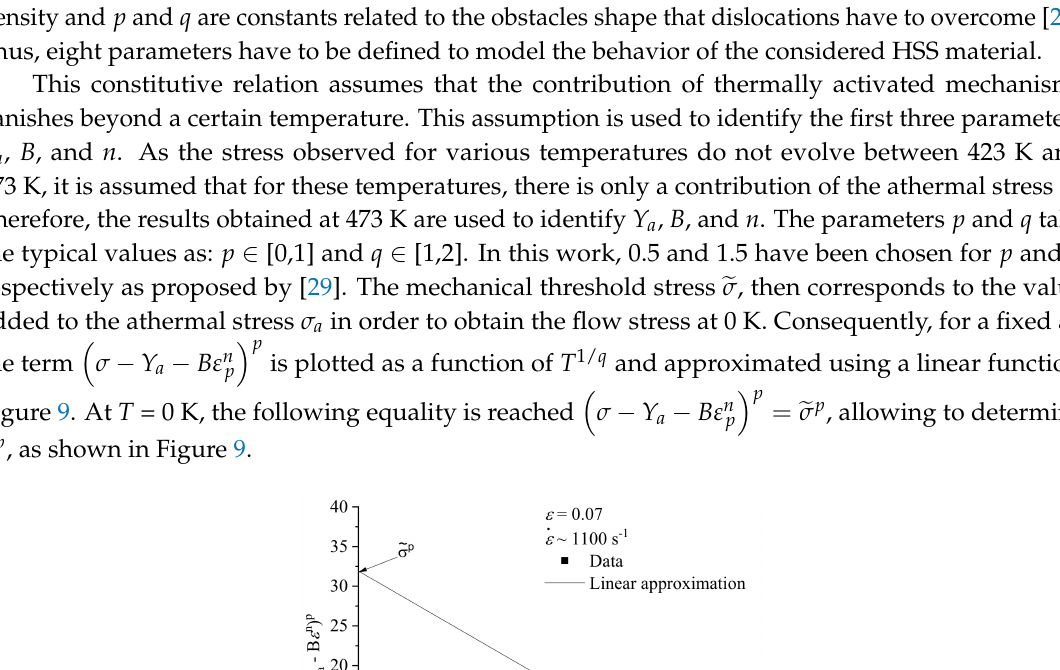
(cid:16) (cid:17) p p , allowing to determine = σ − Y a − B ε n (cid:101) σ p